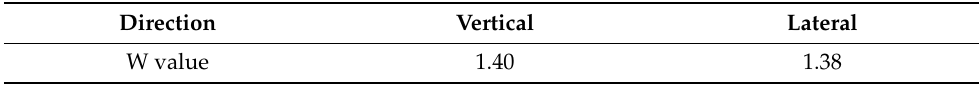
Table 5. The calculated values of the Sperling stability index with rail fastener failure.